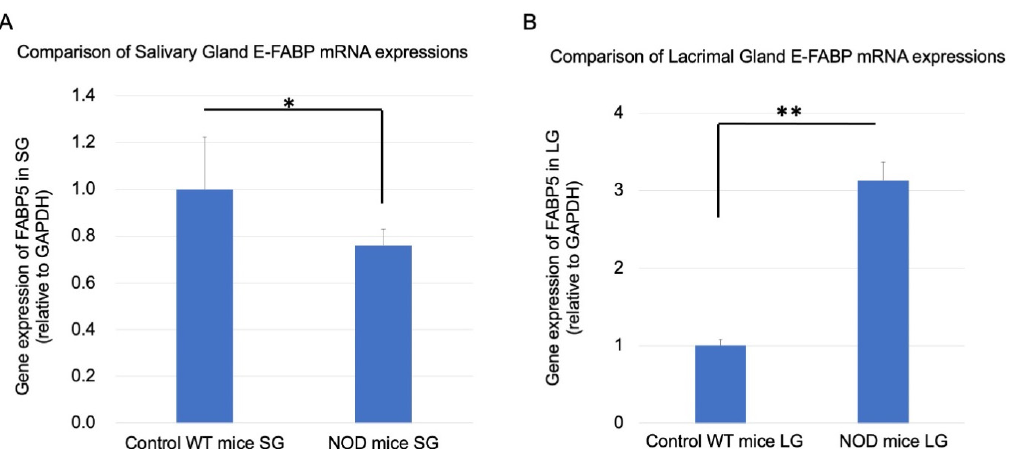
Figure 6. Comparison of E-FABP mRNA expressions in the salivary and lacrimal glands of the wild-type (WT) and the NOD mice. ( A ) In the salivary glands, the E-FABP mRNA expression in the NOD mice was significantly lower than that in the WT mice ( p = 0.001). ( B ) In the lacrimal glands, the E-FABP mRNA expression in the NOD mice was significantly higher than that in the WT mice ( p = 0.0008). * and ** represent p < 0.05 and p < 0.001, respectively.SG: salivary gland LG:lacrimal gland GAPDH: glyceraldehyde phosphate dehydrogenase.